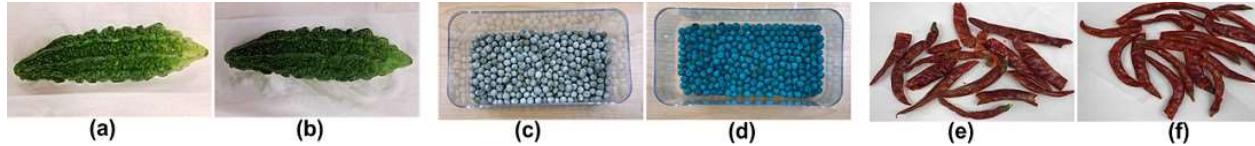
Figure 5. Comparison between the raw and dyed vegetables: ( a ) raw okra, ( b ) okra dyed with copper sulfate, ( c ) raw peas, ( d ) peas dyed with malachite green, ( e ) raw red chilies, and ( f ) red chilies dyed with Sudan red.